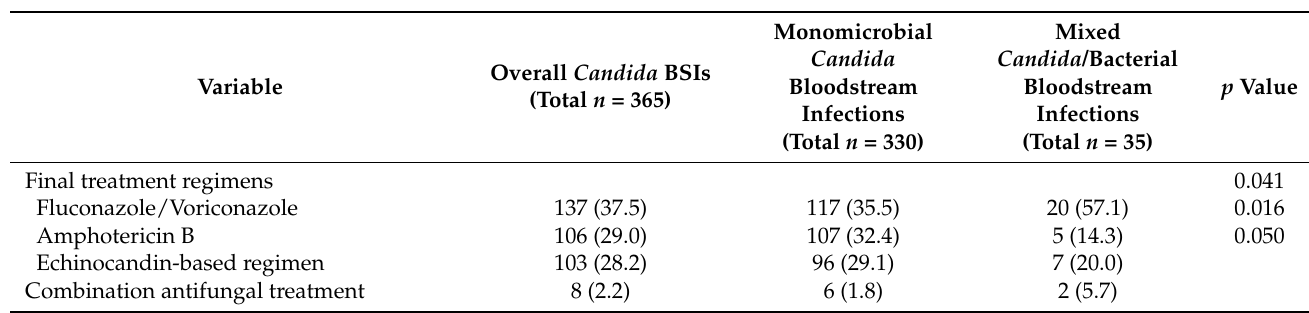
Table 3. Therapeutic strategies and outcome comparisons of pediatric Candida bloodstream infections (BSIs) and mixed Candida/bacterial